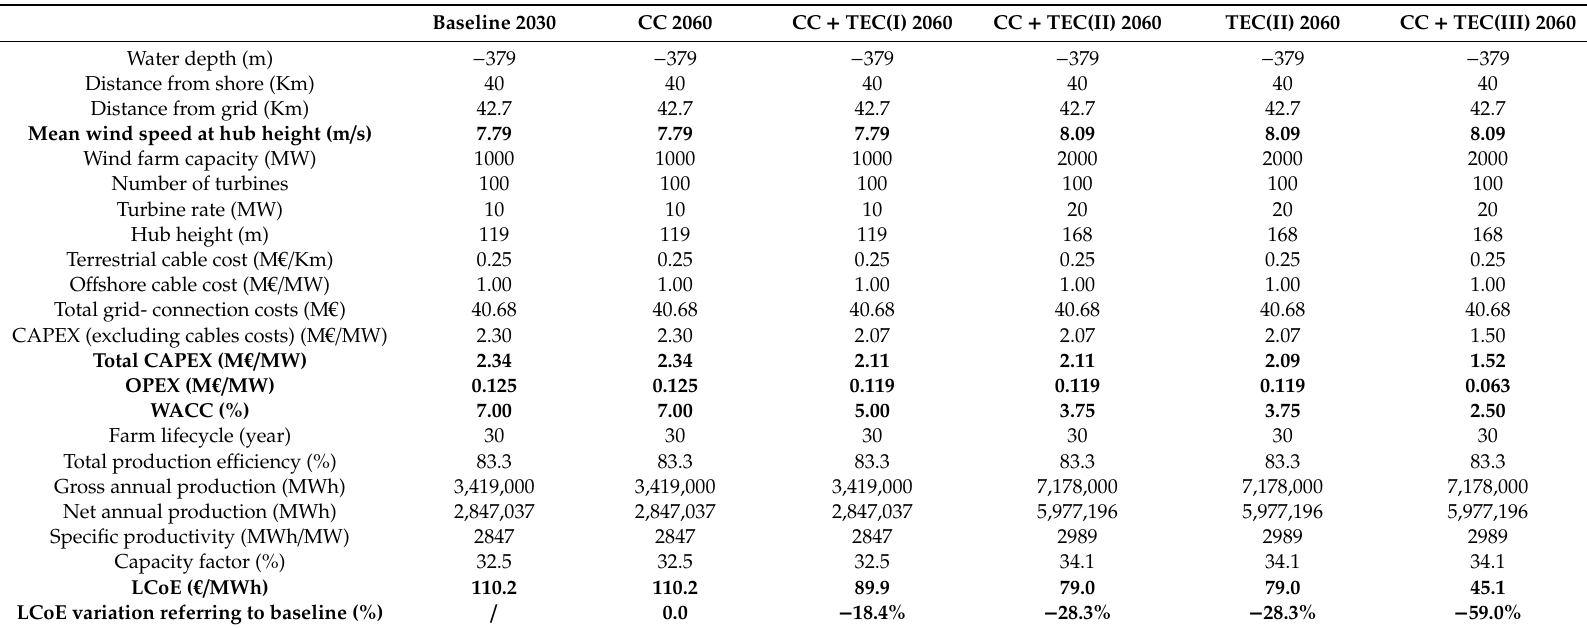
Table 5. Case study 1 (Apulia); net wind speed variation: − 0 m / s. (Variable parameters in